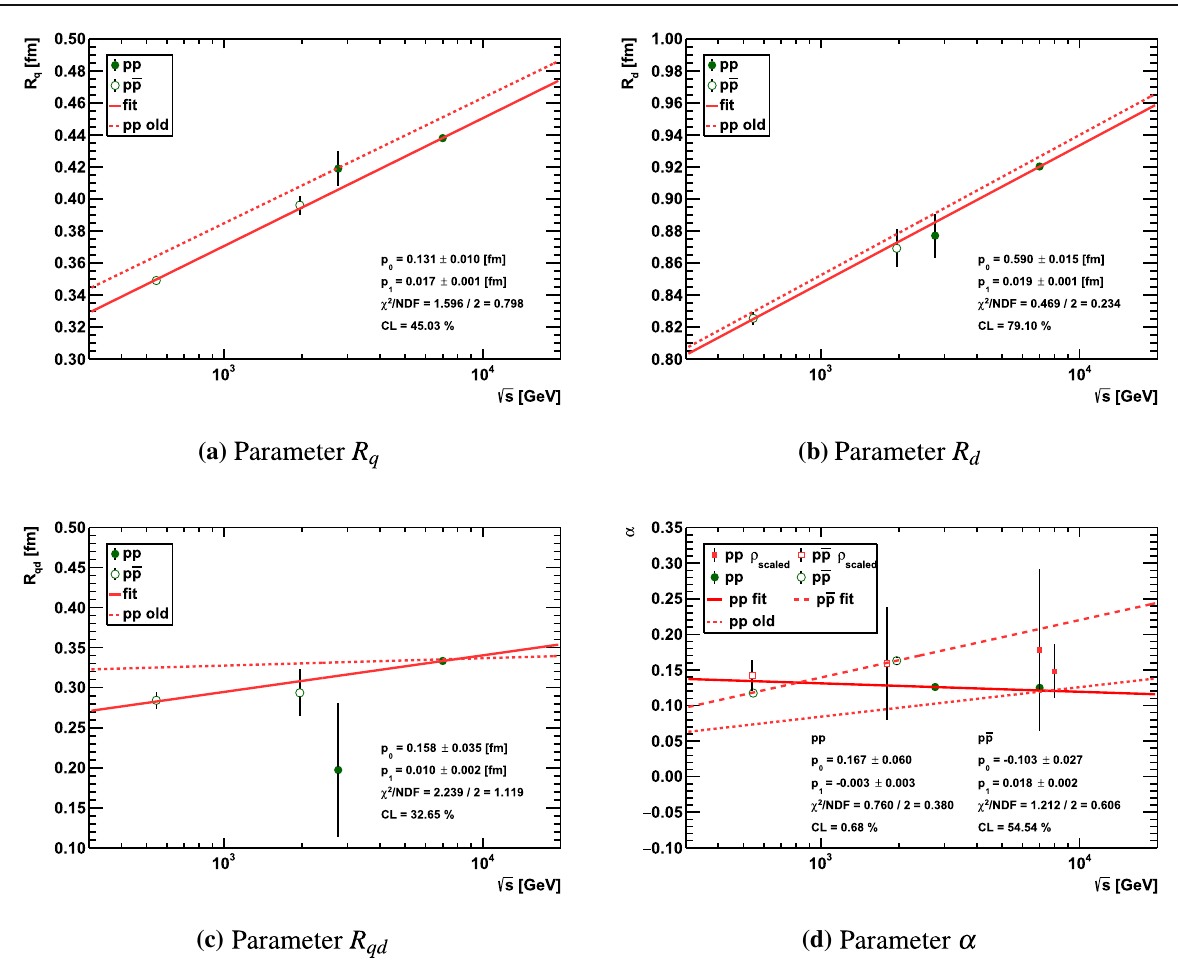
Fig. 6 The energy dependence of the parameters of the ReBB model, R q , R d , R qd and α , collected in Table 1 and determined by fitting a linear logarithmic model, Eq. (10), to each of them one by